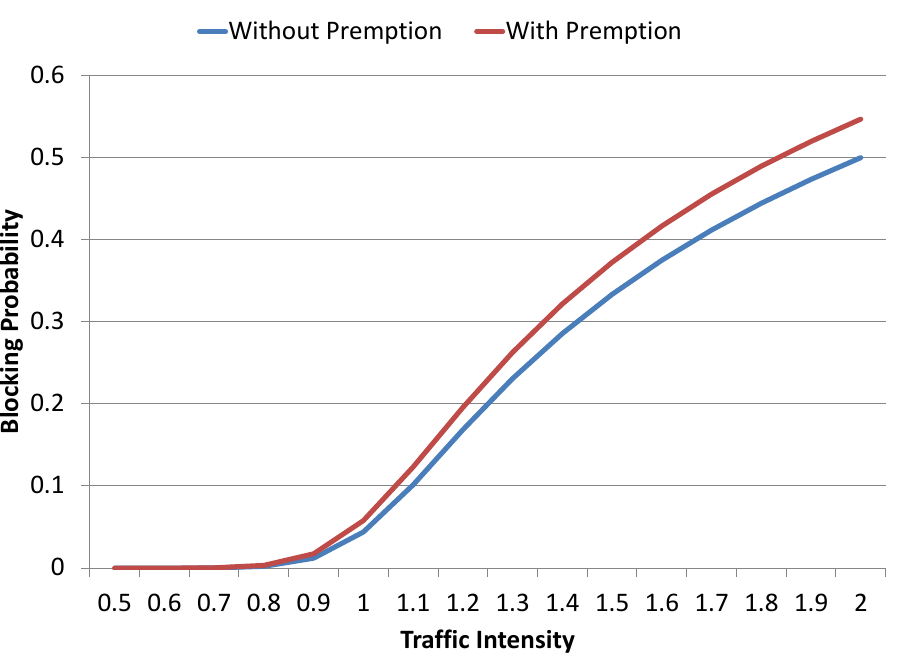
Figure 10. Validation of Model results through simulation with C = 30 Gbps